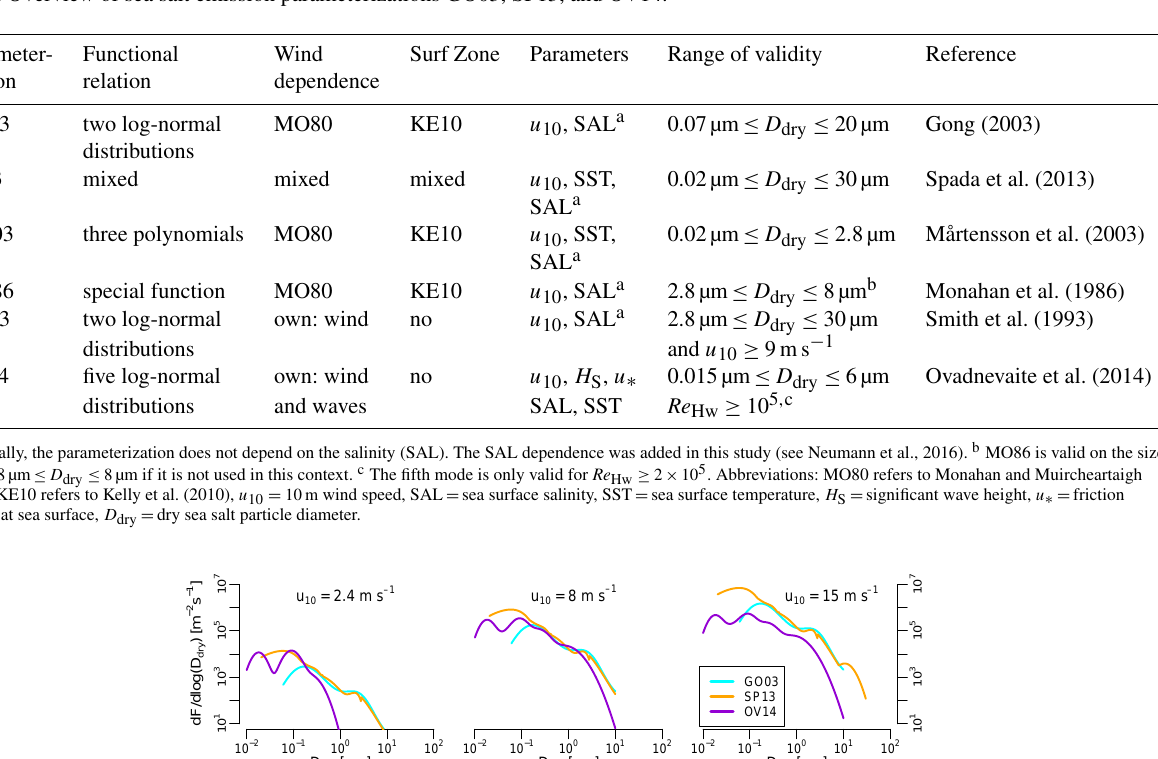
Table 1. Overview of sea salt emission parameterizations GO03, SP13, and OV14.